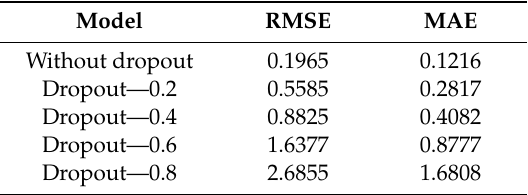
Table 5. LSTM performance with variation in dropout.